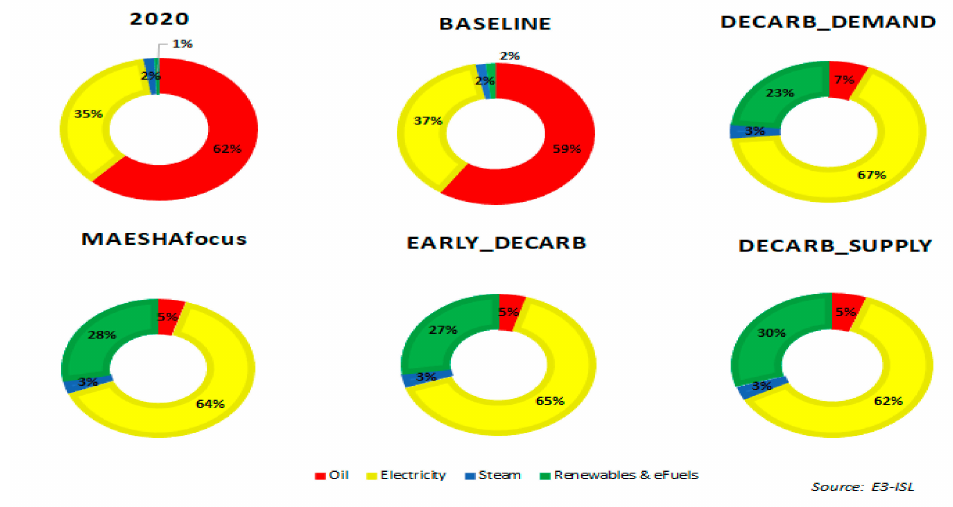
Figure 8. Fuel shares of final energy consumption by scenario in